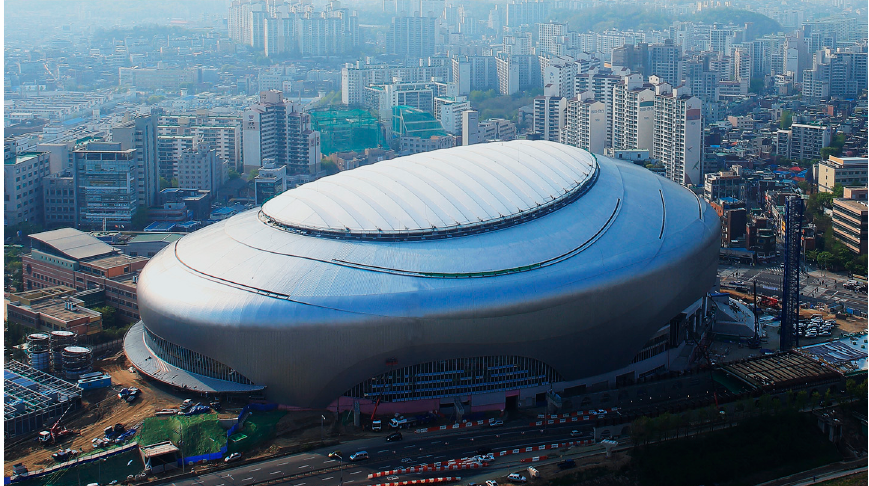
Figure 3. Target building.